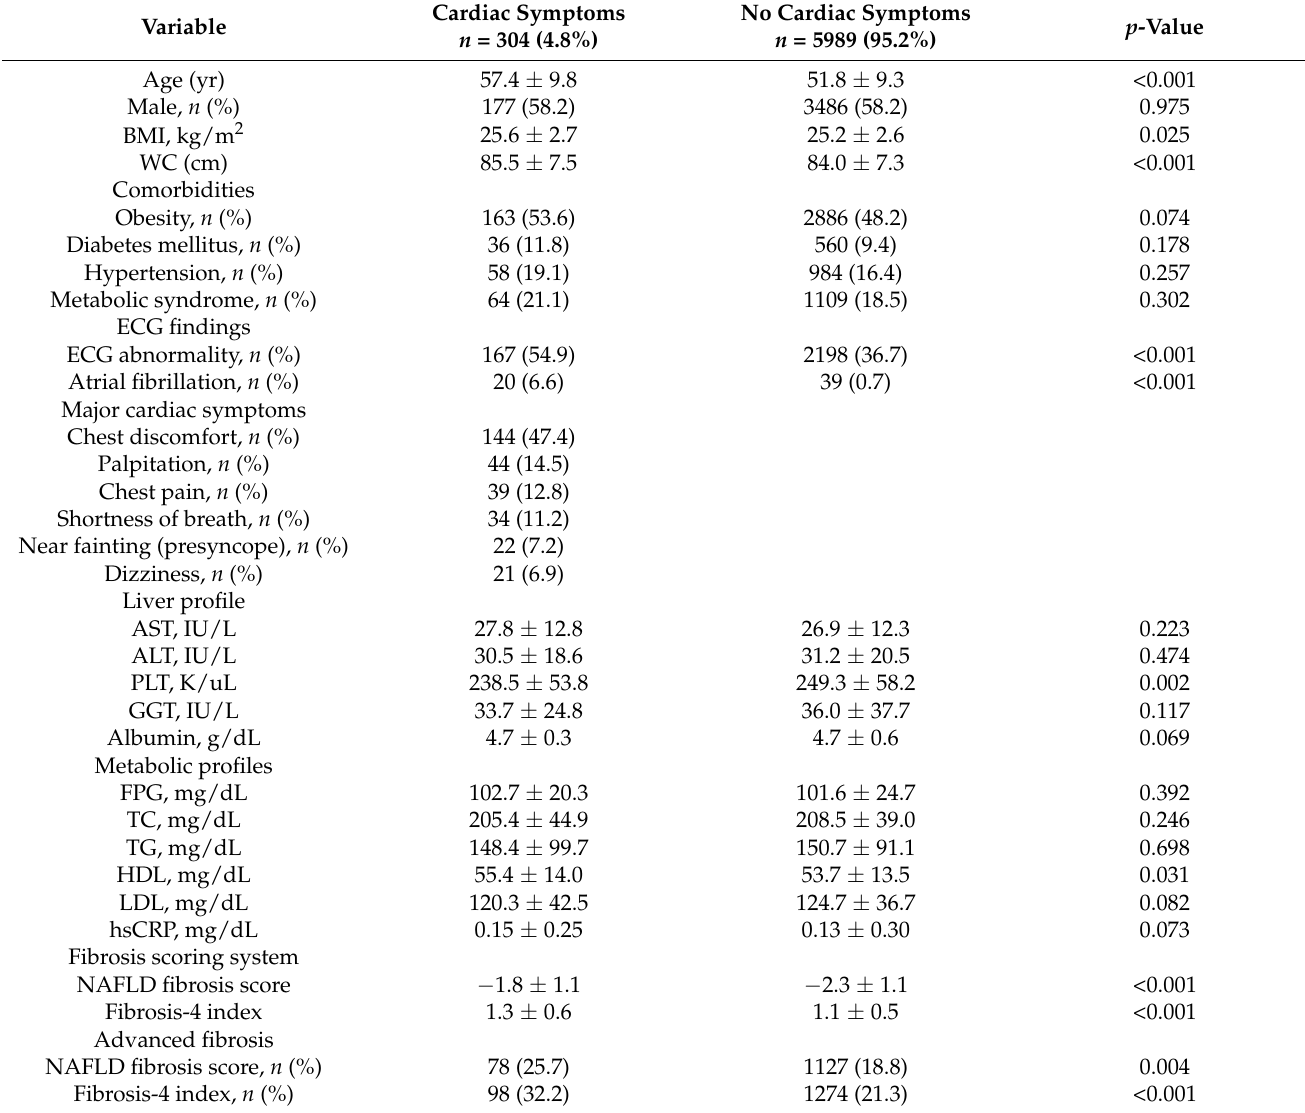
Table 1. Baseline